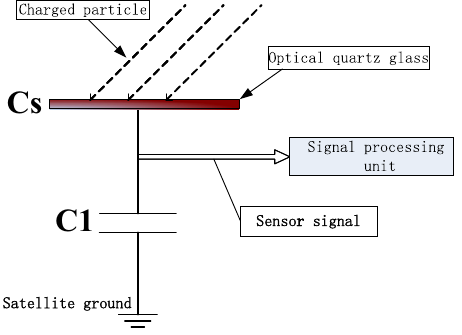
Figure 8: Working principle of the charge detector.